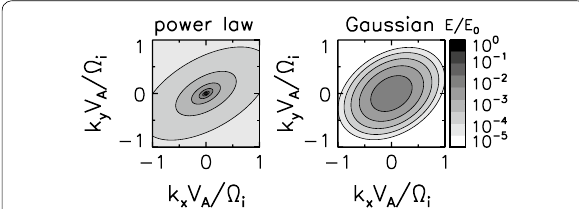
Fig. 7 Elliptic power-law spectrum ( left panel ) and a Gaussian fit using the moment tensor method ( right panel ). Color bar scale shows levels of the spectral energy density in the two-dimensional wavevector domain, so the squared fluctuation amplitude divided by the square of wavenumber interval. The fluctuation amplitudes are normalized to the mean field (e.g., magnetic field) and the wavenum- ber interval to the ion inertial scale. The color bar scale is normalized here, and reads E / E kk , where E kk = B 2 0 V 2 A /� 2